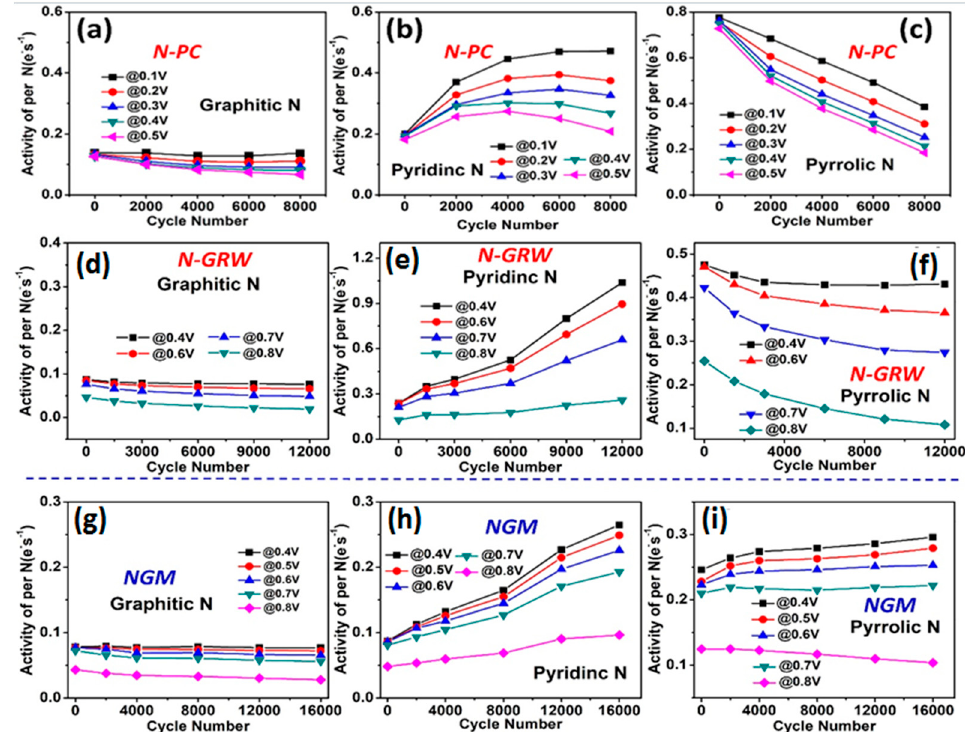
Figure 12. Plots for showing the evolution of specific activity against cycling number for ( a , d , g ) graphitic N, ( b , e , h ) pyridinic N and ( c , f , i ) pyrrolic N in ( a – c ) N-PC ( d – f ) N-GRW and ( g – i ) NGM.